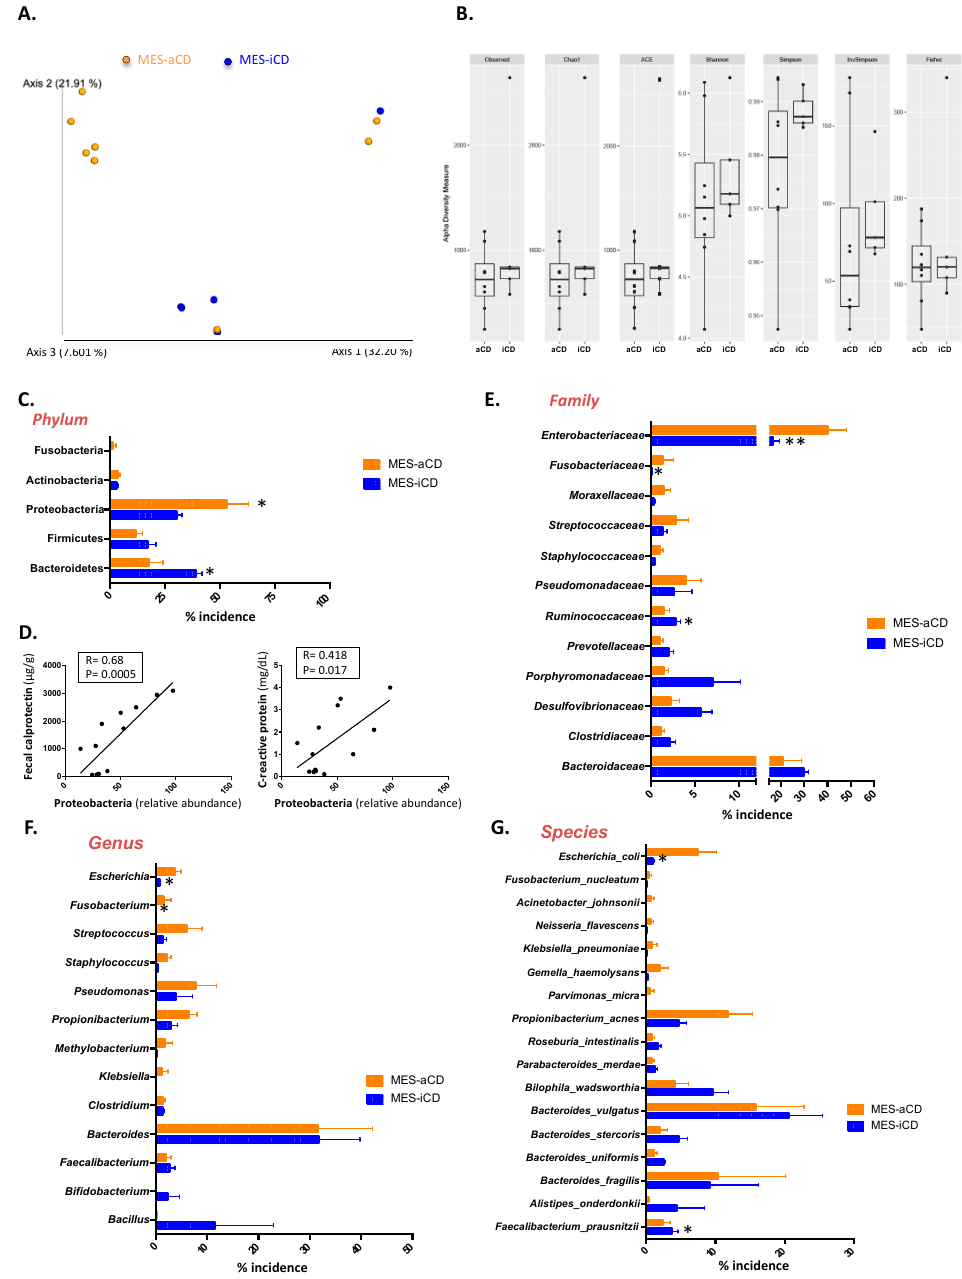
Figure 2. Distinct microbiome signatures in visceral adipose tissue of patients with active / inactive Crohn’s disease. ( A ) Weighted UniFrac principal coordinates analysis of microbiome data from mesenteric-visceral adipose tissue ( MES -VAT) of patients with active or inactive Crohn’s disease (CD) shows two distinct clusters. ( B ) α -diversity indices (Observed, Chao1, ACE, Shannon, Simpson, InvSimpson, and Fisher) of the microbiome of MES -VAT of patients with active or inactive disease. ( C ) Percentage of the abundance of phylum levels between MES -VAT of active and inactive patients. ( D ) Positive correlation between Proteobacteria (relative abundance) and fecal calprotectin or C-reactive protein. Percentage of incidence in ( E ) family, ( F ) genus, and ( G ) species taxon levels in MES -VAT of patients with active or inactive disease. Data information: for B, data are represented in box-and-whisker plot format (whiskers: min to max). For C and E to G, values are expressed as mean ± SEM. Statistical analyses: Two-way analysis of variance with post hoc Bonferroni multiple comparisons test. For D, Pearson’s correlation analysis with Bonferroni adjustment was used. *, p < 0.05; **, p <